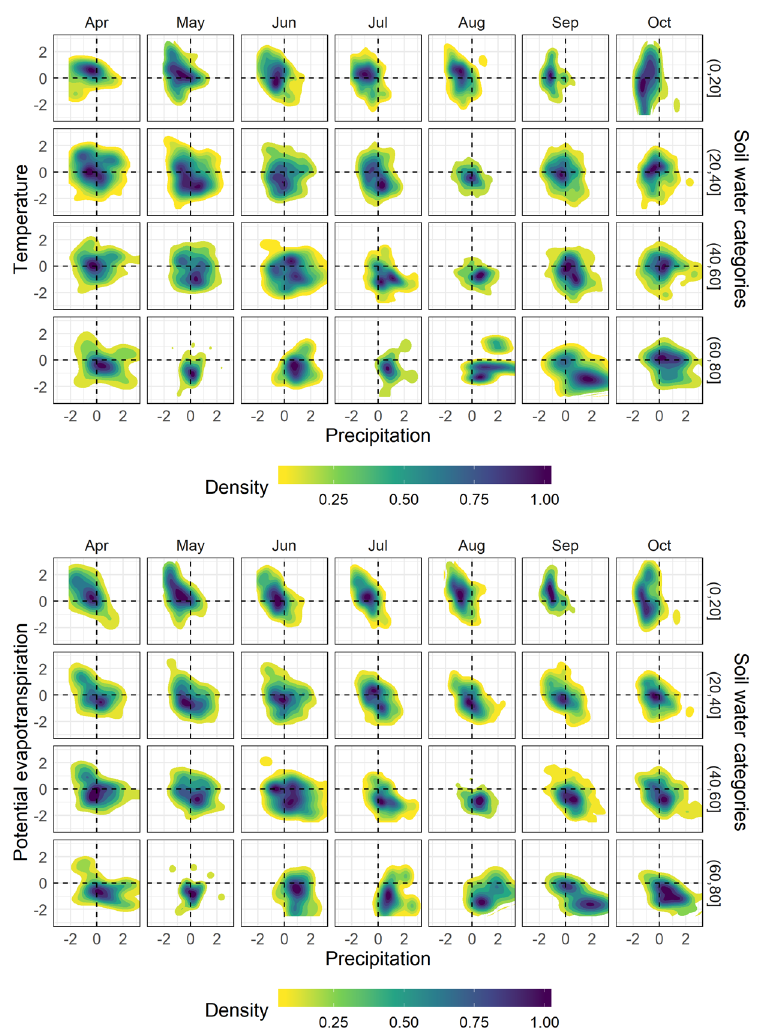
Fig. 2. Distribution of standardized 30-day precipitation amount and air temperature (above) or potential evapotranspiration (below) values during different surface (0–20 cm) soil water conditions (0–20, 20–40, 40–60 and 60–80 mm). The 0 represents mean conditions, the divergence from mean is shown in standard deviations. Darker colors represent a larger reoccurrence of meteorological